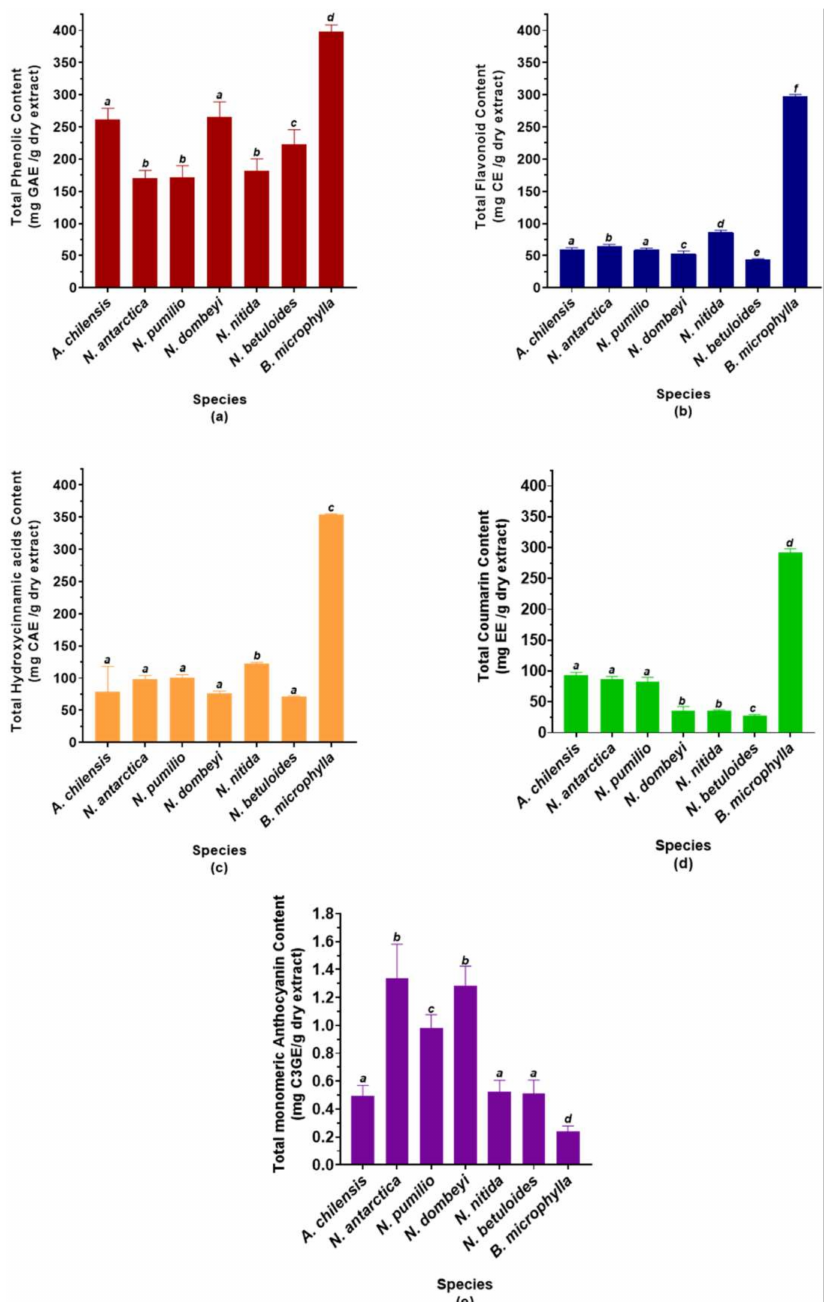
Figure 1. Phytochemical screening of the studied species. Data are expressed as means ± SD (n = 9). ( a ) Total phenolic content, expressed as gallic acid equivalent (GAE) per gram of dry extract. ( b ) Total flavonoid content, expressed as catechin equivalent (CE) per gram of dry extract. ( c ) Total hydroxycinnamic acids derivatives content, expressed as caffeic acid equivalents (CAEs) per gram of dry extract. ( d ) Total coumarin content, expressed as esculetin equivalents (EEs) per gram of dry extract. ( e ) Total monomeric anthocyanin content, expressed as cyanidin 3- O -glucoside per gram of dry extract. The different letters on the bars indicate significant differences with an average value of p < 0.05, Tuckey’s